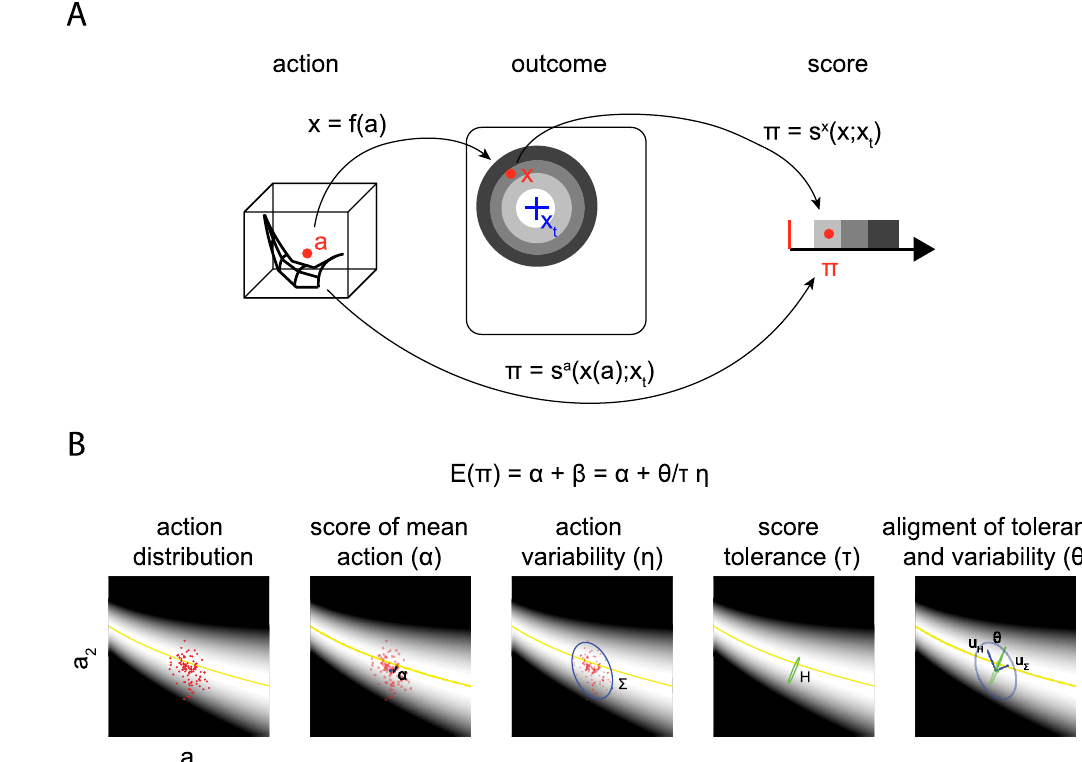
Fig 2. Definition of variables (action, outcome, and score) and schematic overview of the proposed approach to decompose the mean score (performance). (A) An action, represented by a vector a in a high-dimensional action space (illustrated by a red circular marker in a three-dimensional action space), leads to an outcome, x = f ( a ), i.e. a vector typically represented in outcome or goal space with less dimensions. The outcome is then associated with a corresponding score, π = s x ( x , x T ), based on its relation with respect to the aimed target. The set of points in action space associated with an outcome achieving the goal constitute the solution manifold (illustrated by the black mesh). (B) Illustration of the Hessian-based decomposition of the mean score in the case of two- dimensional actions. The action-to-score mapping is represented by the gray-shaded areas. A set of actions (small red markers, first panel ) has a distribution characterized by the mean (large blue marker, second panel ) and covariance ( S , blue ellipse in the third and fifth panels ). The tolerance of the score to variations of the actions around their means is characterized by the Hessian ( H , green ellipse in the fourth panel ). The mean score ( E ( π )) is decomposed as the sum of the score of the mean action ( α ) and a tolerance- variability index ( β ) expressed as the product of three terms: the reciprocal of tolerance ( τ ), noise ( η ), and alignment ( θ ), i.e. a scalar characterizing whether the most sensitive directions of the Hessian (green arrows u H , fifth panel ) are aligned to the directions of highest action variability (blue arrows u S